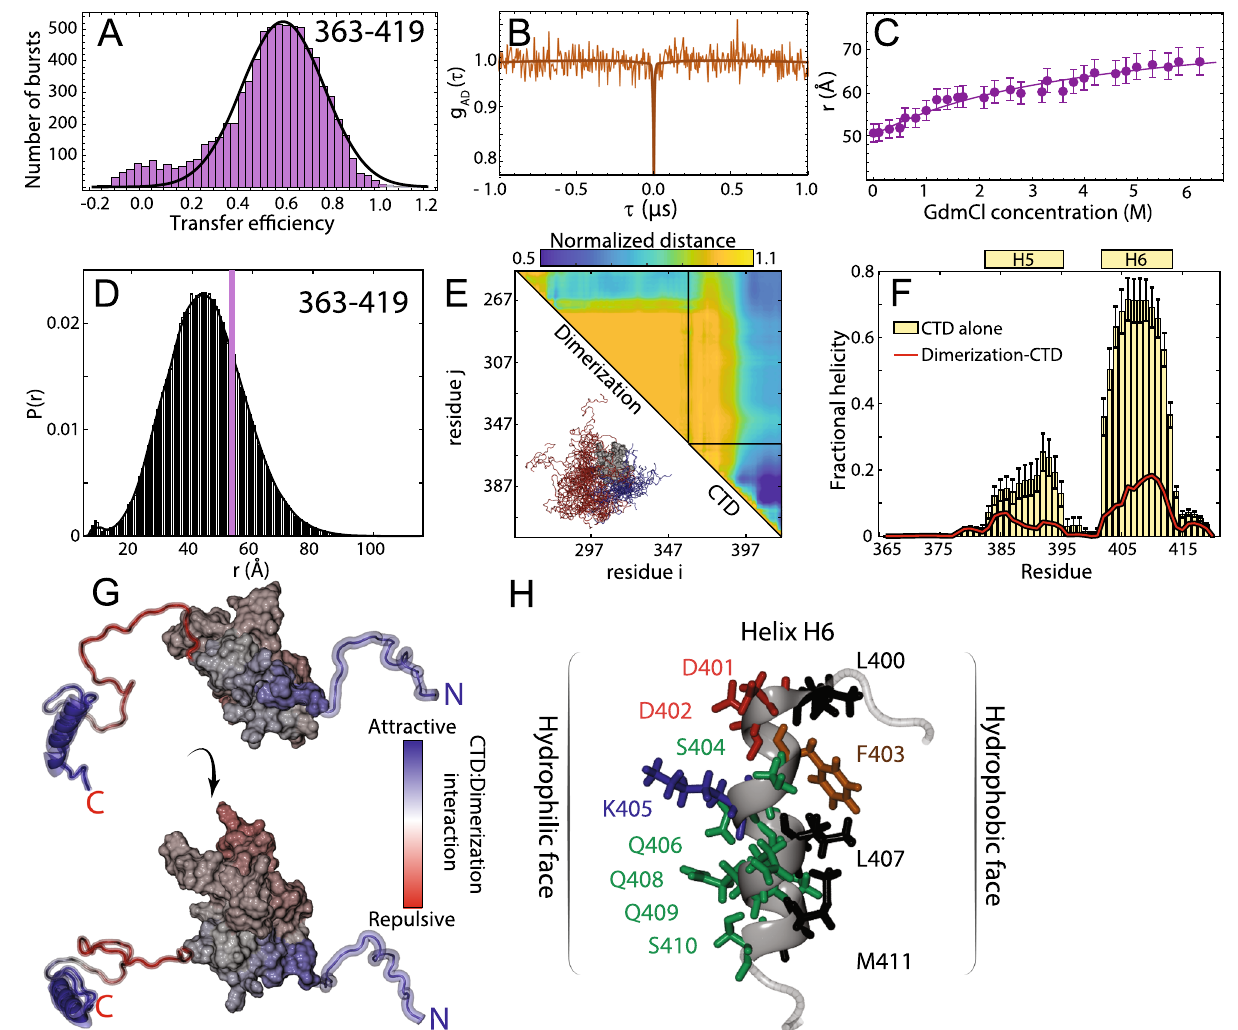
Fig. 4 The C-terminal domain (CTD) is disordered, engages in transient interaction with the dimerization domain, and contains a putative helical- binding motif. A Histogram of the transfer ef fi ciency distribution measured across the labeling positions 363 and 419 in the context of the full-length protein, under aqueous buffer conditions. B Donor – acceptor cross-correlation measured by ns-FCS (see SI). The fl at correlation indicates a lack of dynamics in the studied timescale or the coexistence of two populations in equilibrium whose correlations (one correlated and the other anticorrelated) compensate each other. C Interdye distance as extracted from single-molecule FRET experiments across different denaturant concentrations. The full line represents a fi t to the model in Eq. (S6), which accounts for denaturant binding. Error bars are the propagation of ±0.03 systematic error in measured transfer ef fi ciencies (see SI). D Inter-residue distance distributions calculated from simulations (histogram) show good agreement with distances inferred from single-molecule FRET measurements (purple bar). E Scaling maps describe the average inter-residue distance between each pair of residues, normalized by the distance expected if the CTD behaved as a self-avoiding random coil. H6 engages in extensive intra-CTD interactions and also interacts with the dimerization domain. We observe repulsion between the dimerization domain and the N-terminal region of the CTD. F Two transient helices (H5 and H6) are observed in the CTD (residues 383 – 396 and 402 – 415). Both show a reduction in population in the presence of the dimerization domain at least in part because the same sets of residues engage in transient interactions with the dimerization domain. Error bars are standard error of the mean calculated from forty independent simulations. G The normalized distances are projected onto the surface to map CTD-dimerization interaction. The helical region drives intramolecular interaction, predominantly with the N-terminal side of the dimerization domain. H Helix H6 is an amphipathic helix with a polar/charged surface (left) and a hydrophobic surface single-molecule FRET (Fig. 4A) and ns-FCS (Fig. 4B) to under- stand the conformational behavior of the CTD FL construct.